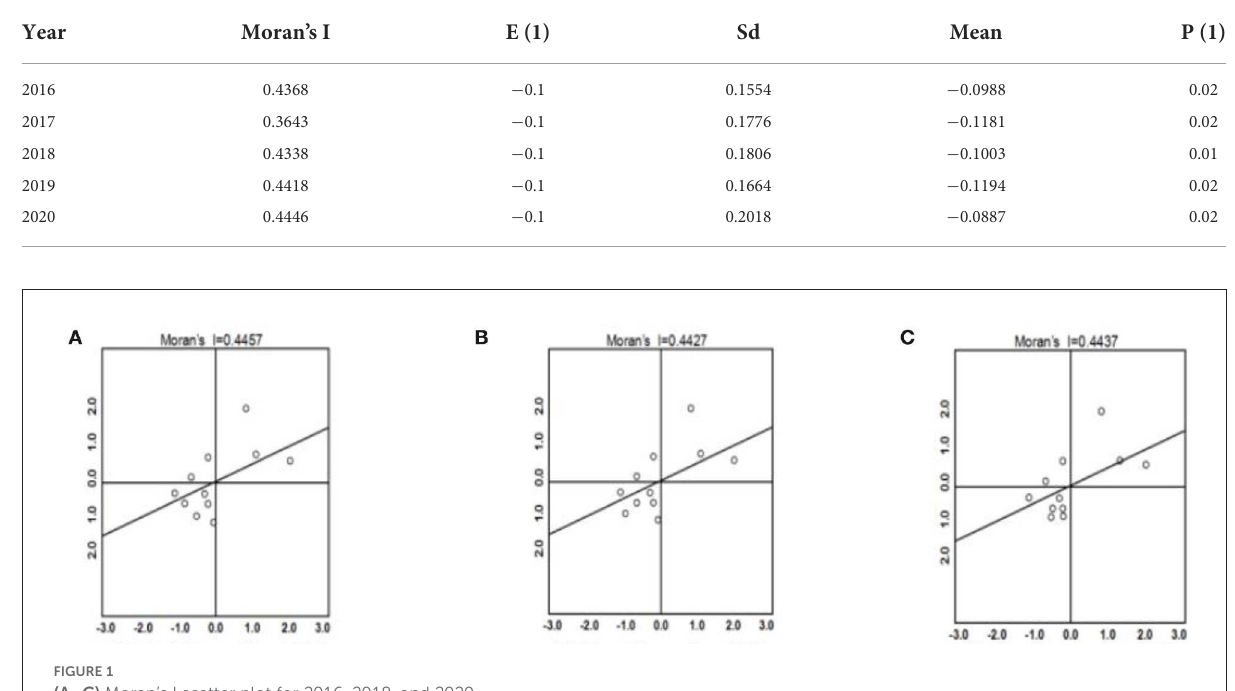
TABLE 5 Global Moran’s I index for smart medical industry development in the Yangtze River Economic Zone.